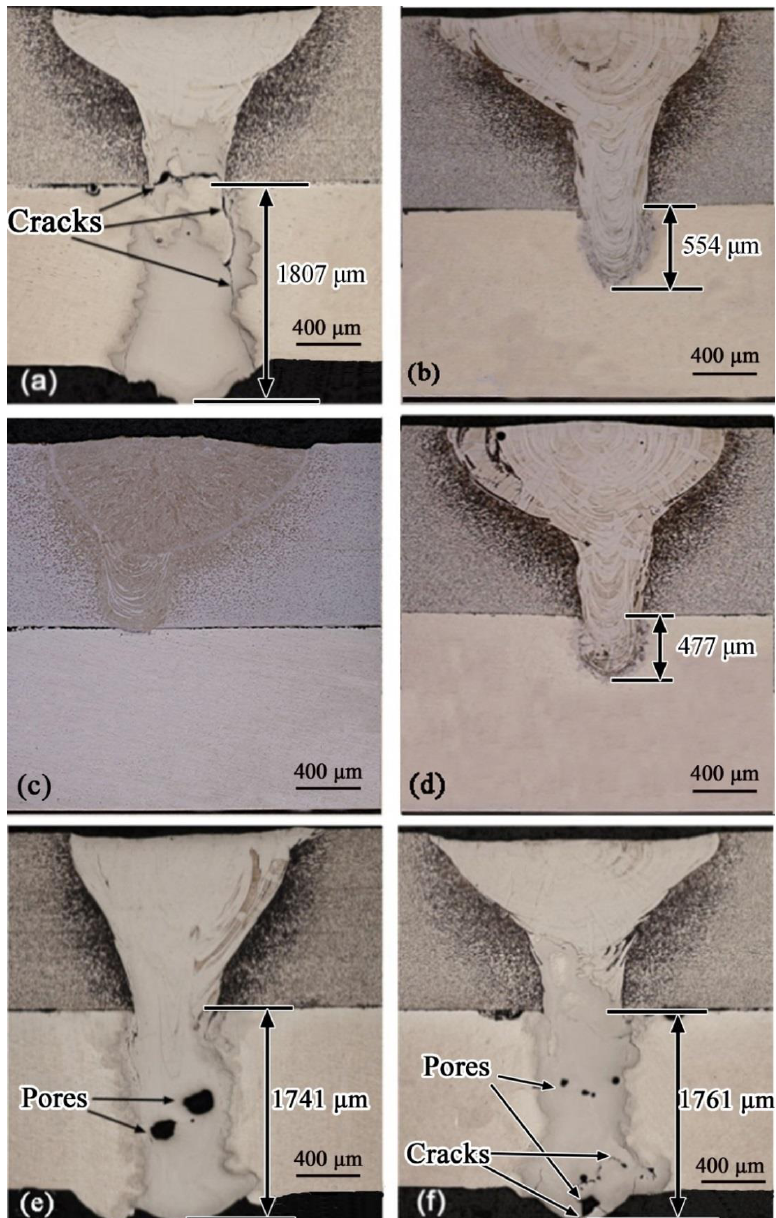
Figure 3. Effects of Rs on the cross sections of the steel/Al joints produced by dual-beam laser welding with side-by-side configuration while the d 1 of 1.0 mm, the P L of 3000 W, the v of 33 mm/s, and the ∆ Z of 0 mm were fixed: ( a ) 0.25; ( b ) 0.50; ( c ) 0.67; ( d ) 1.50; ( e ) 2.00; ( f ) 4.00.